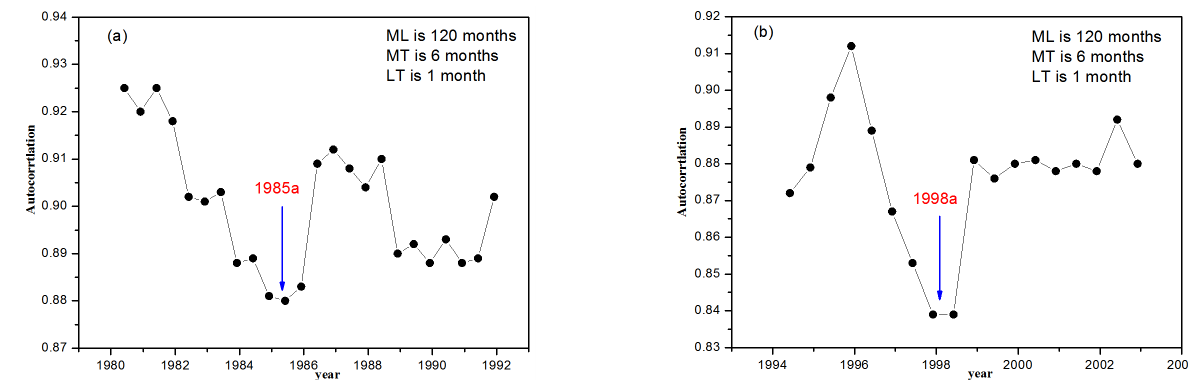
Figure 8. Autocorrelation coefficient signal-based detection for the abrupt changes in ( a ) 1993 and ( b ) 2003 of the SPI sequence over the Dongting Lake basin.